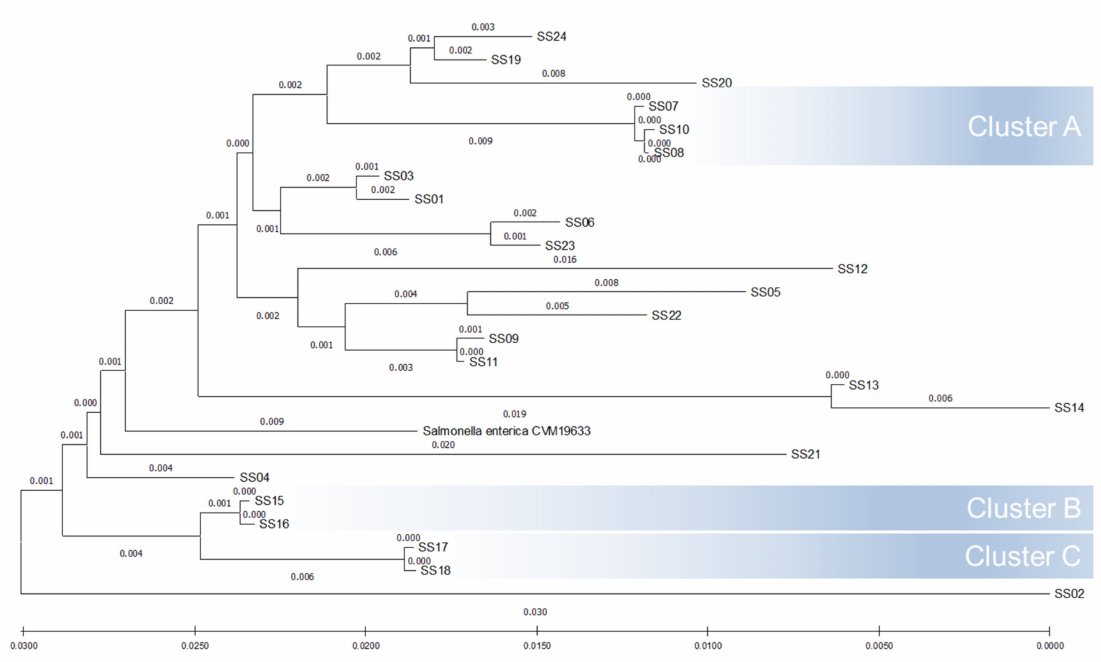
Figure 3. Comparative analysis of 24 S. enterica serovar Schwarzengrund isolates built using MUMi and neighbor-joining method (20 genotypes; DI = 0.982). The MUMi distance varies from 0, for very similar genomes, and 1, for very dis- tant